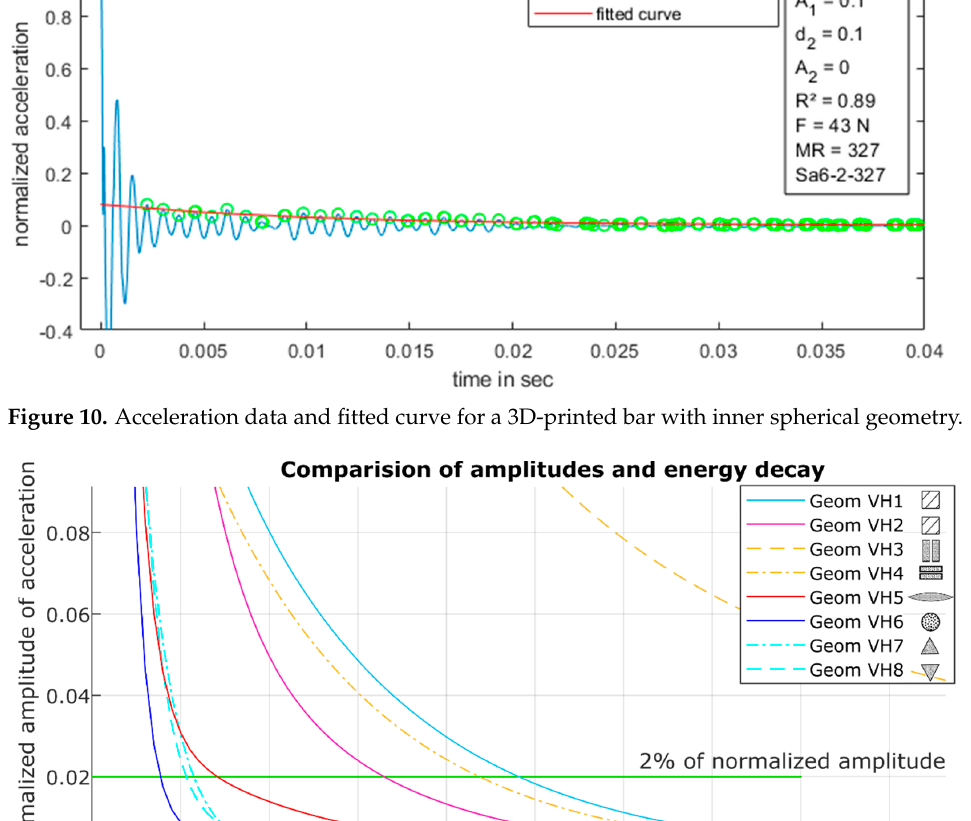
Table 1. Overview of the parameters for function â damp .